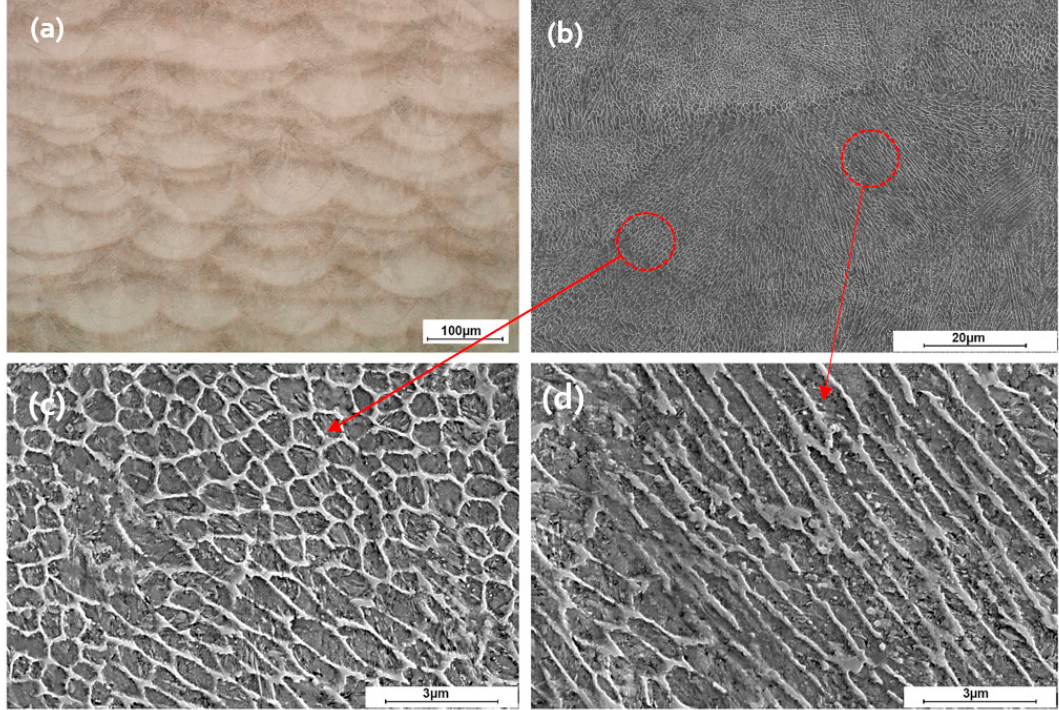
Figure 12. Microstructure of SLM-processed sample in as-built condition along the build direction: ( a ) Optical microscopy of a cross-section; ( b ) SEM micrograph of a melt-pool; ( c ) higher magnification of an area showing fine equiaxed dendrite; and ( d ) higher magnification of an area representing columnar dendrite.